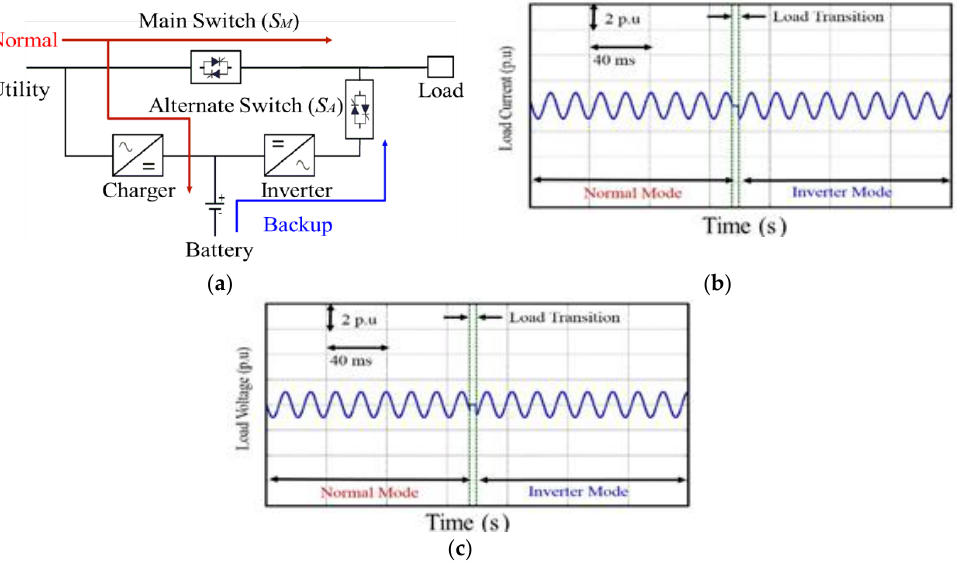
Figure 1. ( a ) Basic diagram of a single-phase offline UPS system without load transformer; ( b ) load current; and ( c ) load voltage.